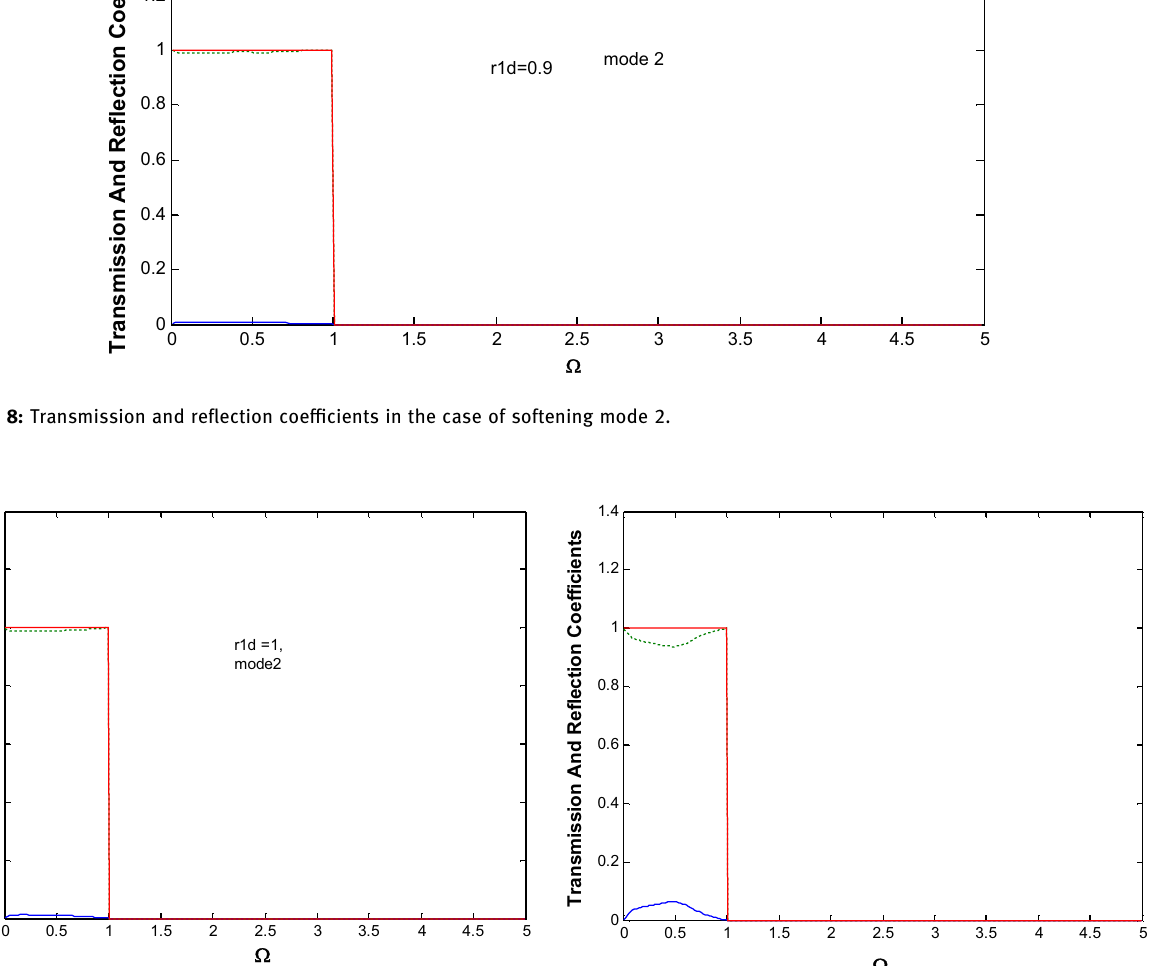
Figure 10: Transmission and re fl ection coe ffi cients in the case of hardening mode